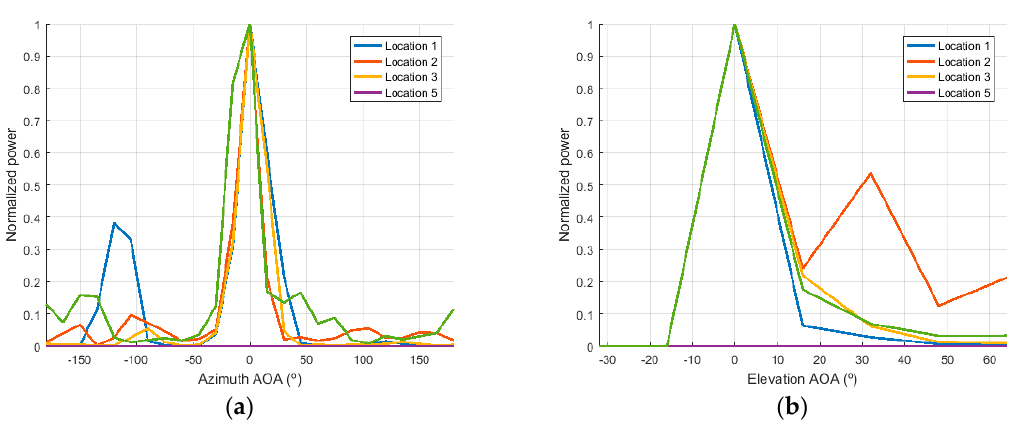
Figure 9. APDs for urban environment ( a ) azimuth and ( b ) elevation.